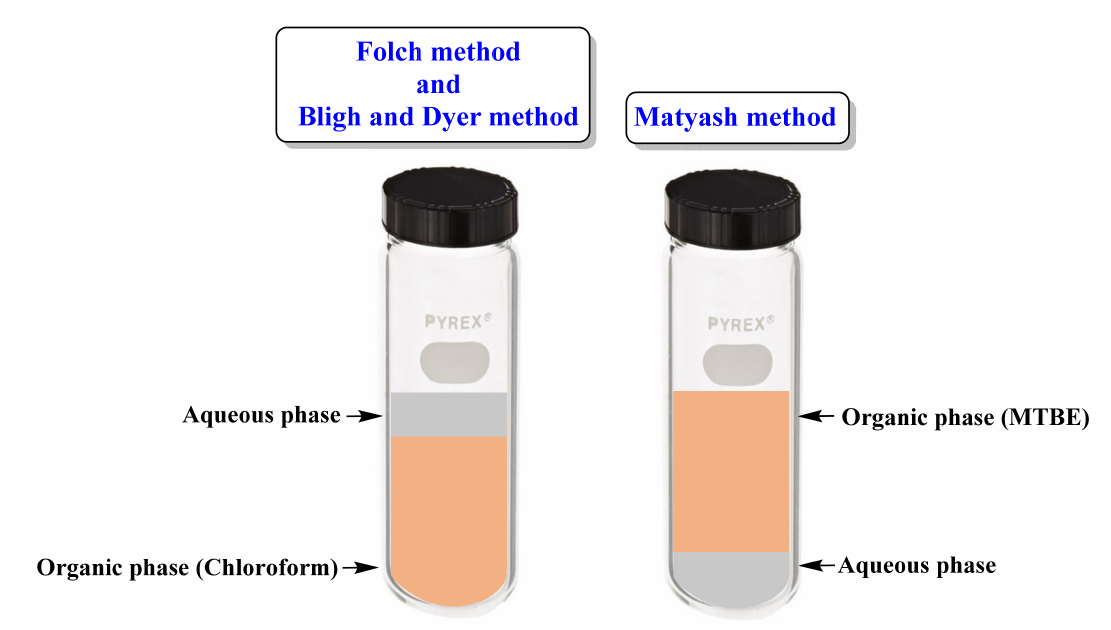
Figure 3. Illustrations showing the phase separation in chloroform-based (Folch method and Bligh and Dyer methods) [7,8] and methyl-tert-butyl ether (MTBE; Matyash Method) [12] based extraction methods. Compared to the lipid-rich chloroform layer below the aqueous phase (in chloroform-based extraction). Moreover, the nonextractable matrix, including proteins (forms at the bottom of the tube), can be removed by centrifugation